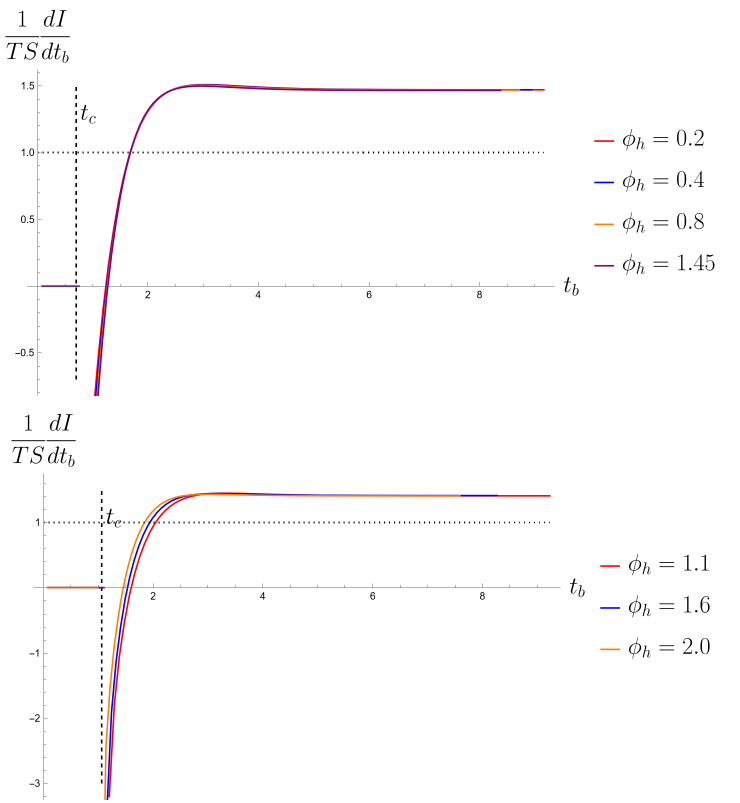
Figure 18 . Time dependence of the action complexity rate in various type D examples. Top: q = 0 and ρ = 2 . Down: q = 1 and ρ = 0 . 6 . In these examples we set z h = 1 and L ct = 1